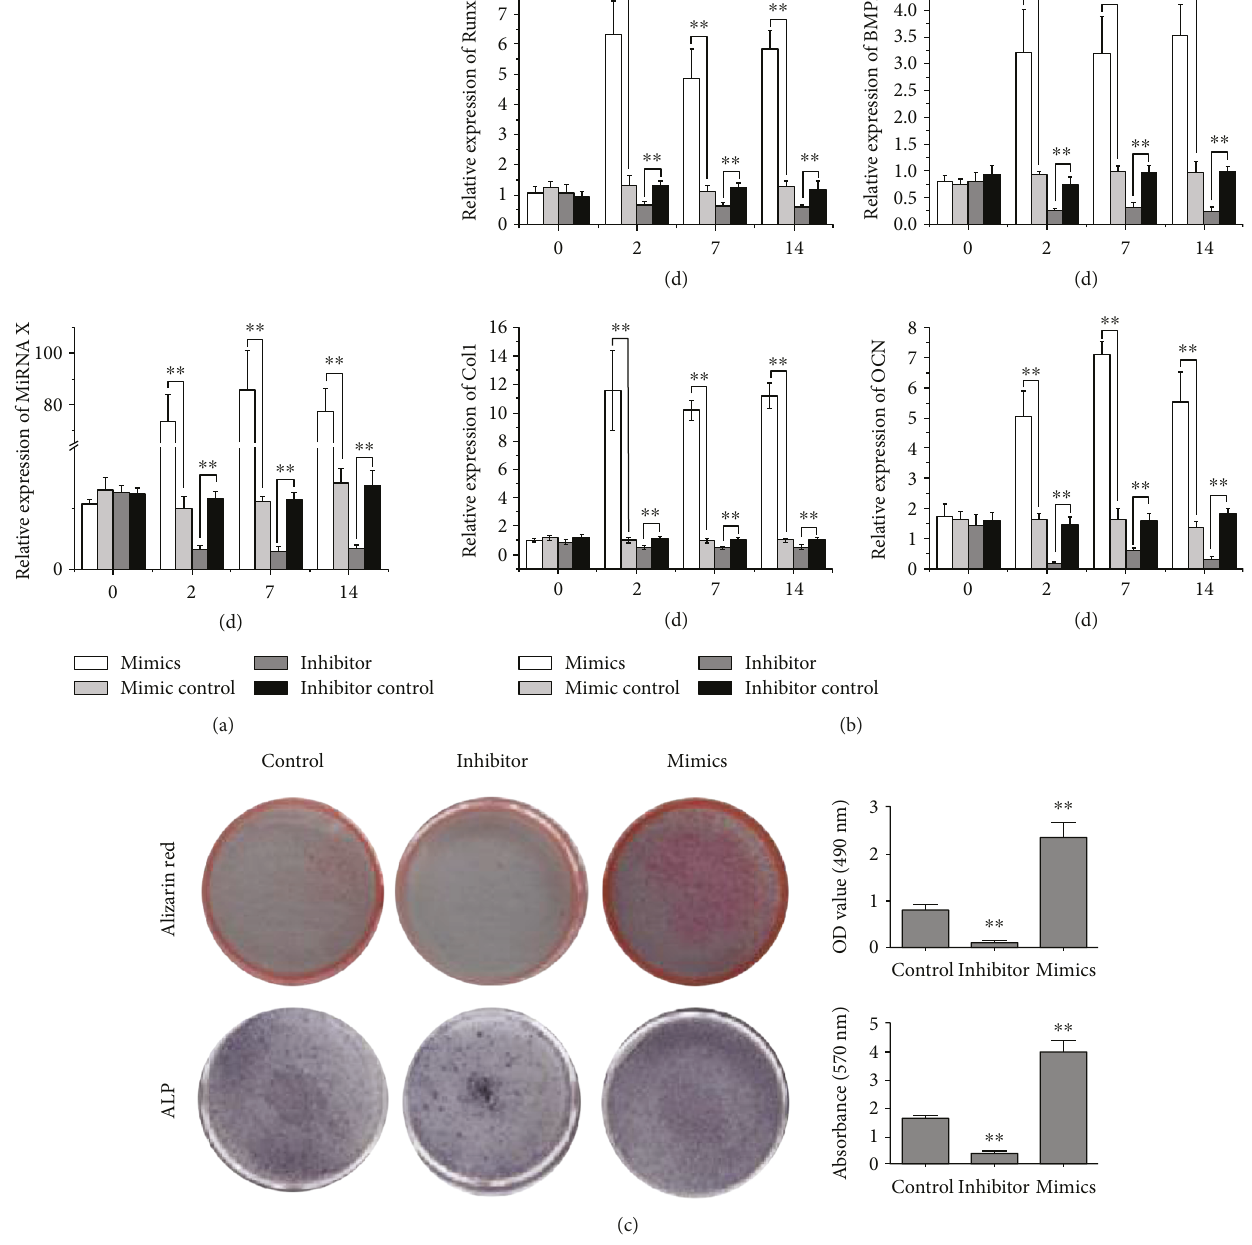
Figure 3: MiR-378 enhanced osteogenesis in vitro. BMMSCs that were transfected with miR-378 mimics, miR-378 inhibitor, or the miR- negative control. (a) MiR-378 expression was enhanced and reduced by transfection of miR-378 mimics and miR-378 inhibitor. (b) Osteogenesis gene (Runx2, BMP2, Ocn, and Col1) was evaluated by qRT-PCR for angiogenesis enhancement at di ff erent time points after transfection including 2, 7, and 14 days. (c) ALP and alizarin red staining were enhanced and reduced by overexpression and inhibition of miR-378 expression, respectively. ∗ P < 0 05 and ∗∗ P < 0 01 ; n = 3